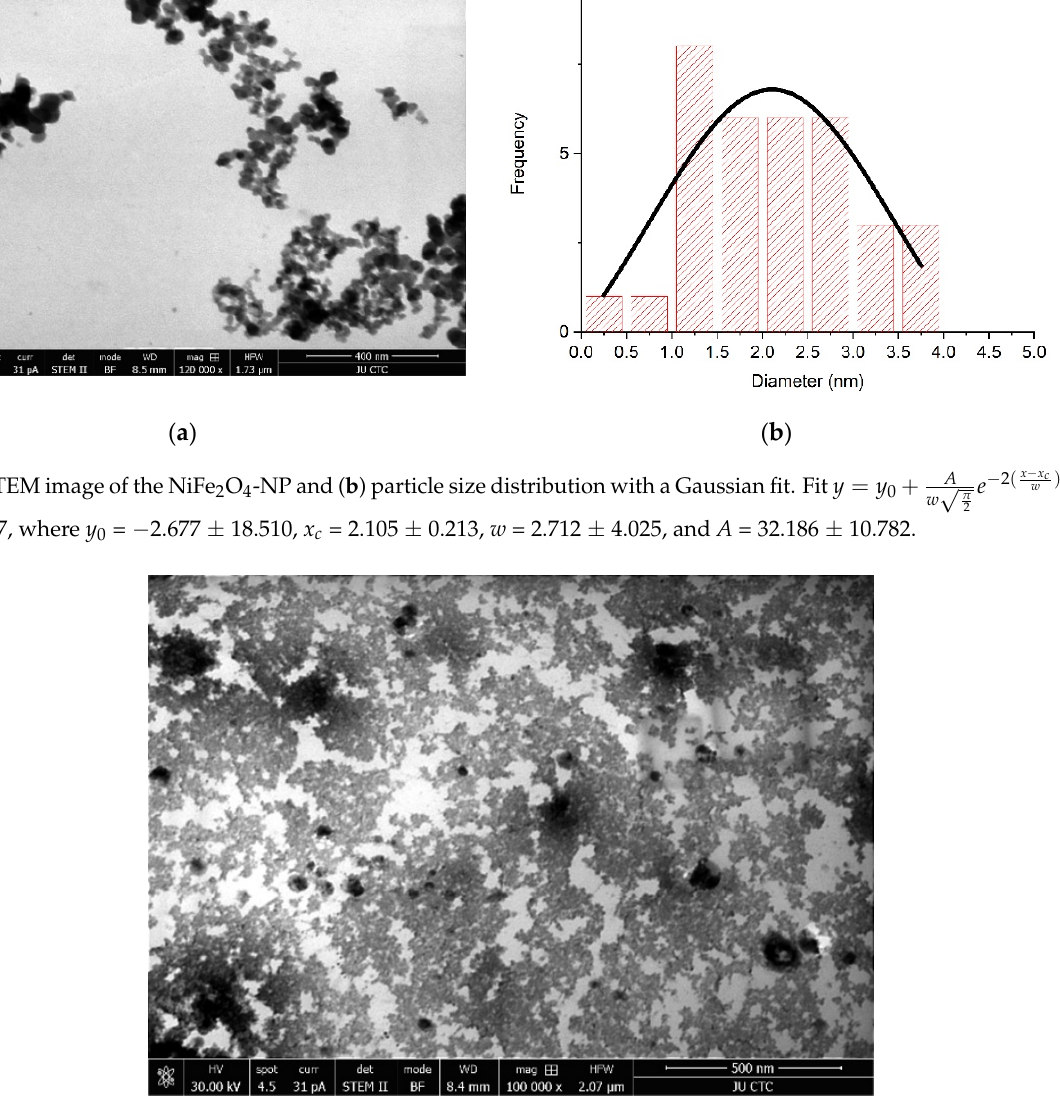
Figure 3. Field emission scanning electron microscopy (FESEM) image of the NiFe 2 O 4 -NPs.